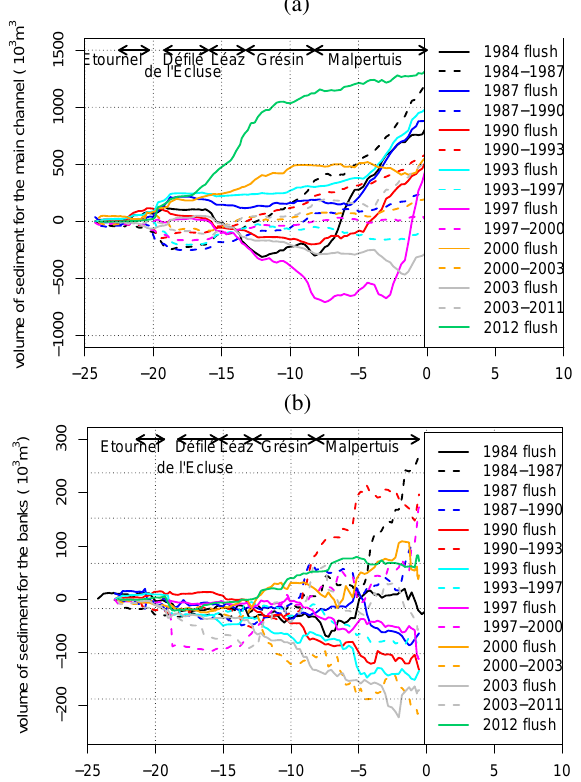
Fig. 5. Spatially cumulated sediment volume budget in Génissiat reservoir since 1984 separating main channel (a) and banks (b) – The main channel contribution is about 80 % of the global budget ans so prevails to the overall reservoir dy- namics.